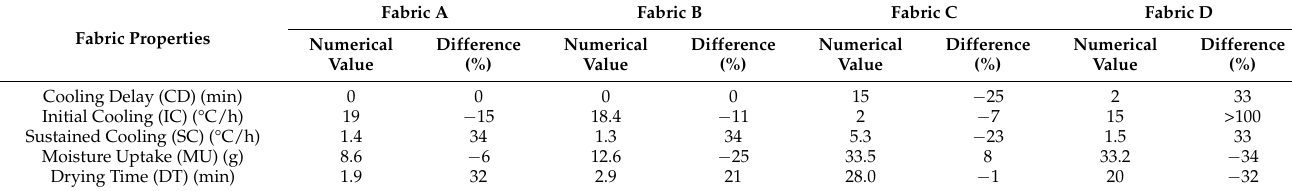
Table 5. The numerical results of phases 2 and 3. “Difference” refers to the differences between the simulated and experimental (Table 4) values. The negative/positive differences show when the model underestimates/overestimates the fabric